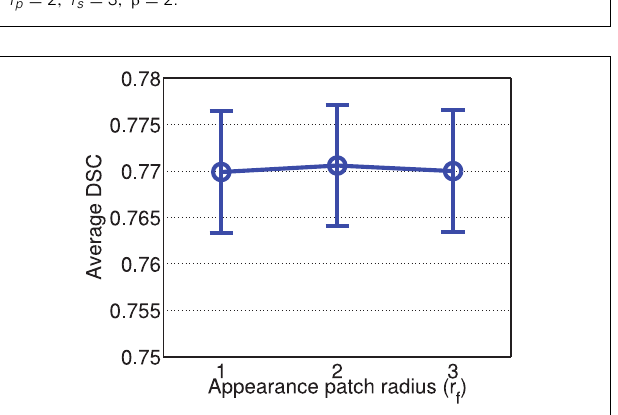
FIGURE 5 | Joint label fusion performance with respect to α (error bars at ± 0.05 standard deviation). Other parameters are set to r p = 2 , r s = 3 , β = 2.